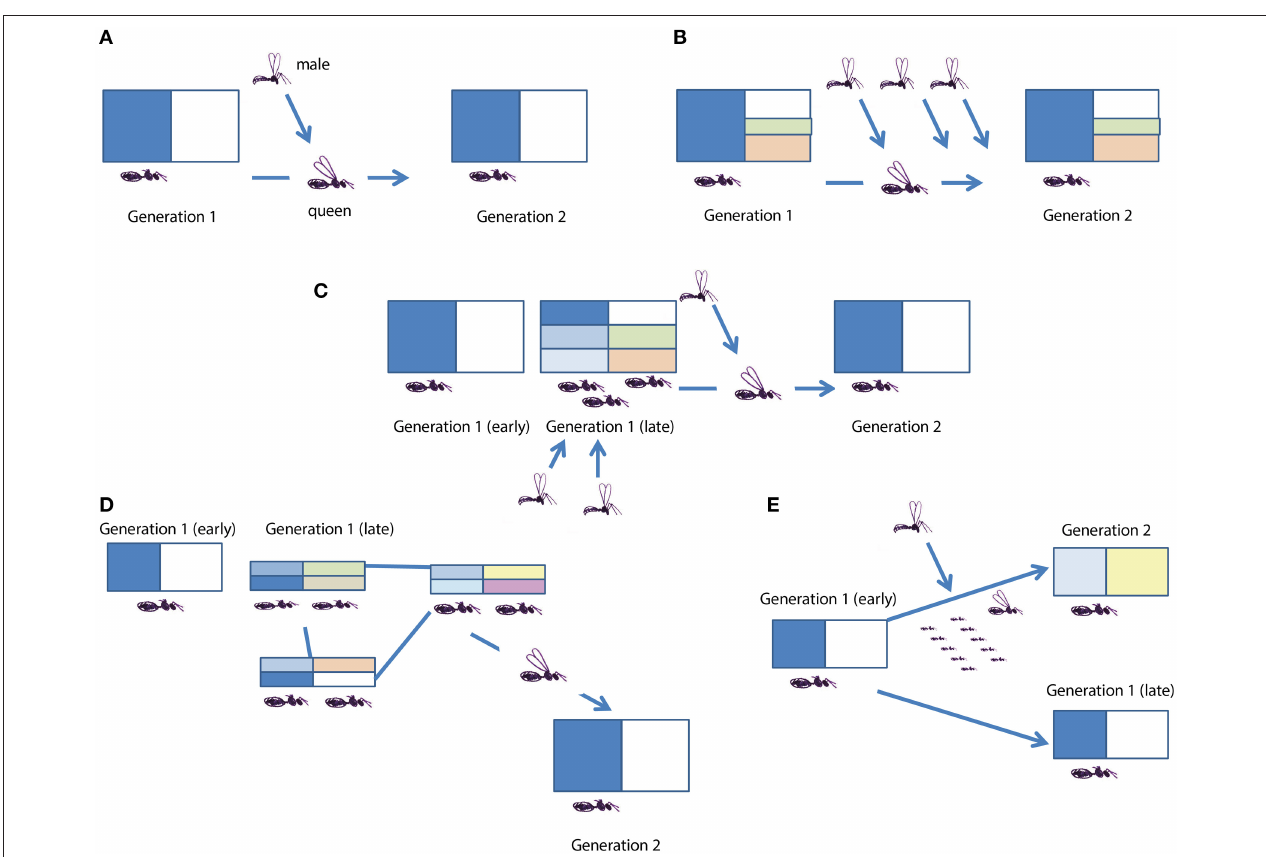
FIGURE 1 | Social insect life cycles. Each block denotes colony consisting of a germline(s)/queen(s) (the bottom part) and soma/workers (the top part). Arrows denote the birth of a new colony, and the move of genetic material to the colony. Colors denote genetic diversity of the colony. In reality, features of many life cycles may be combined (such as multiple mating and multiple queens). In some panels, males are left out for simplicity. (A) The ancestral state, a nuclear family society. Colonies are started independently with one singly mated queen who mates before founding a new colony. There is an extreme genetic and material bottleneck at colony foundation, and genetic material from different parent colonies is mixed at mating. Found in ants, bumble bees and vespine wasps. This is the ancestral form from which all the other life cycles have evolved, once workers have lost their totipotent options. (B) Multiple mating. Colonies are started independently with one multiply mated queen. There is a genetic (severity of which decreased by multiple mating) and strong material bottleneck at colony foundation, and genetic material from different parent colonies is mixed at mating. Compared to the ancestral situation, the colony is genetically more diverse due to several patrilines. Found in ants and vespine wasps. (C) Multiple queen (secondary polygyny). Colonies are started independently with one singly mated queen, but recruit queens that stay in their natal nest and mate in the nest, with nest mate or outside males. There is a strong genetic and material bottleneck at colony foundation, and genetic material from different parent colonies is mixed at mating. The genetic diversity of the nest increases with colony aging and growth. Found in ants. (D) Multiple queens and polydomy. Colonies are started independently with one singly mated queen or through bud nests that get separated from the other nests. Colonies recruit queens that stay in their natal nest or disperse on foot in propagules consisting of queen(s) and workers, and the propagules may or may not maintain long term contact with the mother colony. In the latter case, polydomous colonies, or even large supercolonies emerge. The bottleneck in both genetic and material terms is less severe, since both queens and workers move to new nests. New genetic material is acquired through mating, if males come from outside the colony. The genetic diversity of the nest increases with colony aging and growth. Found in ants. (E) Colony fissioning. Colonies are started dependently by propagules consisting of a queen (or queens) and a large number of workers. The material bottleneck is less severe, since both queens and workers move to new nests, severity of the genetic bottleneck depends on the number of queens moving to new nests. New genetic material is acquired through mating. Found in honeybees, stingless bees, some ants and swarm founding